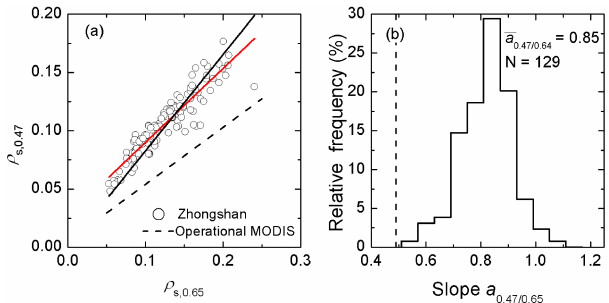
Figure 3. (a) Surface reflectance at 0.47µm ρ s (0.47µm) as function of surface reflectance at 0.65µm ρ s (0.65µm) for Zhongshan. The solid lines represent the linear fits of the measured data with (red) and without (black) an intercept. The dependency of ρ s (0.47µm) and ρ s (0.65µm) in the operational algorithm is shown as dashed line. (b) Relative frequency distribution for all possible ratios of ρ s (0.47µm) and ρ s (0.65µm) representing the slope a 0 . 47 / 0 . 65 for y intercept at 0. The slope of the operational algorithm is shown as dashed